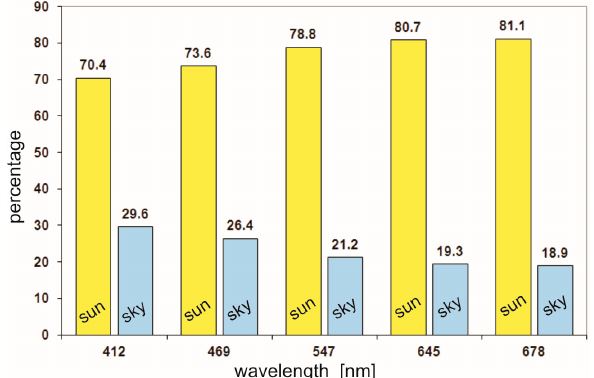
Figure 2. Model percentages of direct solar (yellow bars) and diffuse sky (blue bars) photons for various wavelengths. Direction of the sun beam θ equals 30°.